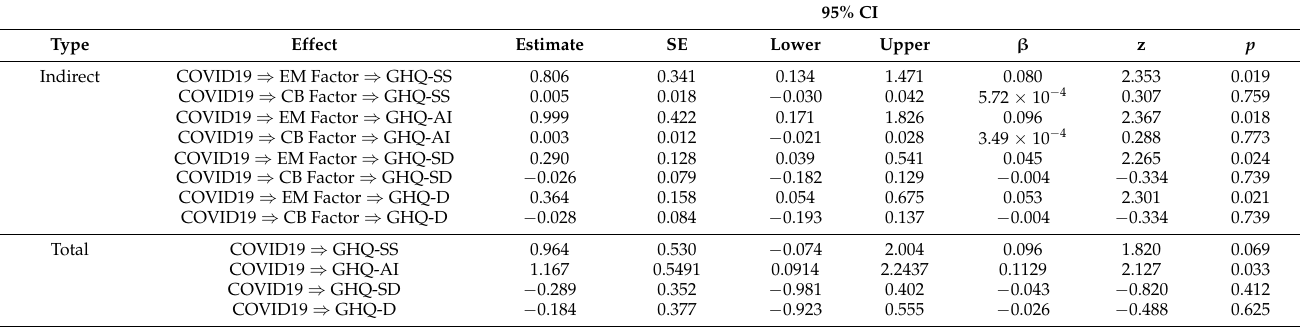
Table 2. Indirect and total effects 95%